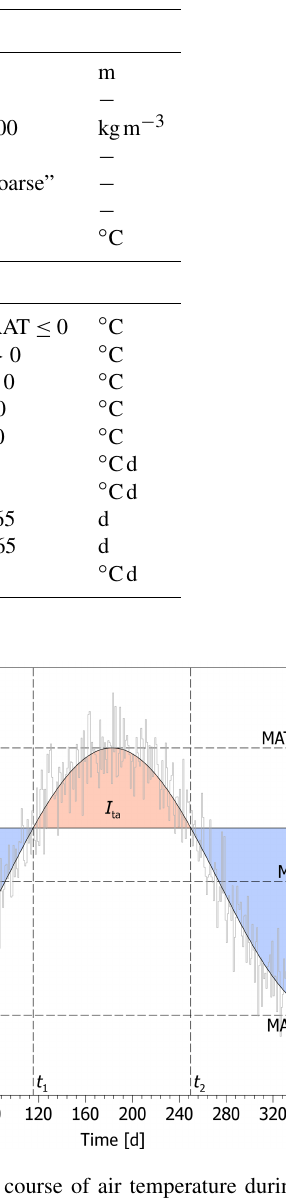
Table 1. List of model input and output variables, their symbols, value ranges, and units. Variable Symbol Value range Inputs Palaeo-active-layer thickness